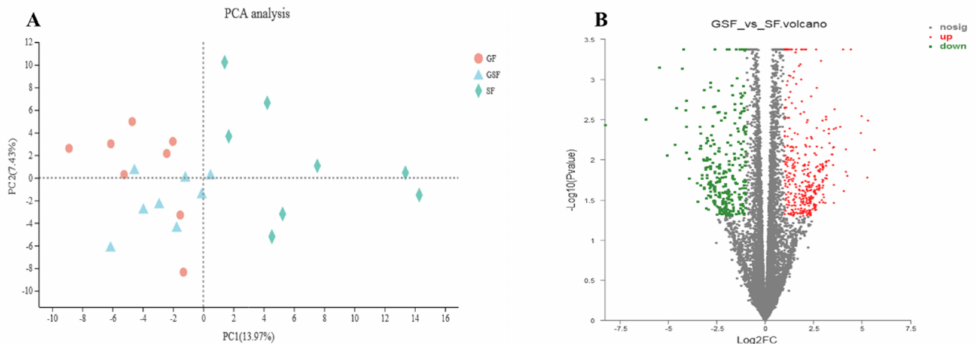
Figure 5. PCA analysis of samples from different feeding systems ( A ) and volcano map of gene expression profile in LD muscle of Tan lamb between the SF and GSF groups ( B ). The green, red, and blue points indicate significant down-regulated, up-regulated, and non-significant difference genes, respectively. GSF, graze-feeding group; SF, stall-feeding group; FC, fold change. n = 8 for each